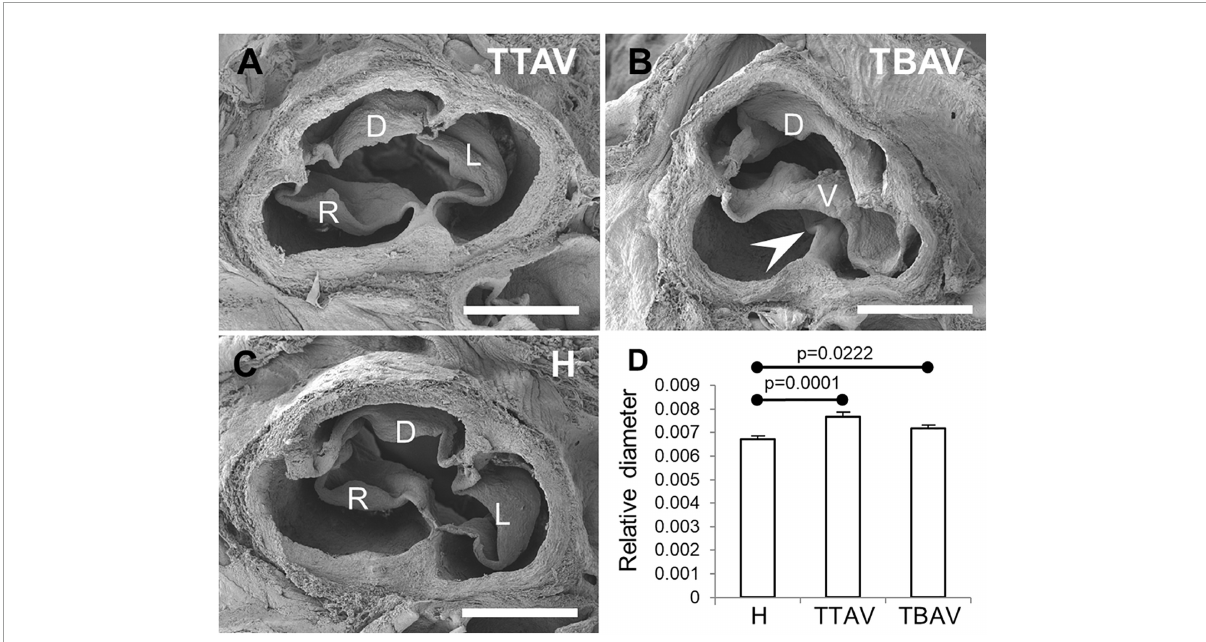
FIGURE1 Scanning electron micrographies of TAVs (A,C) and a BAV (B) of hamsters from the affected (A,B) and the control (C) strains. Cranial views. D, dorsal (non-coronary) leaflet; L, left leaflet; R, right leaflet; V, ventral leaflet. Arrowhead: raphe. Scale bar: 500 µ m. (D) Analysis of the relative diameter of the ascending aorta of hamsters grouped according to the strain and the valve morphology. H, control strain; TBAV, bicuspid aortic valve from the affected strain; TTAV, tricuspid aortic valve from the affected strain. Only significant p -values are